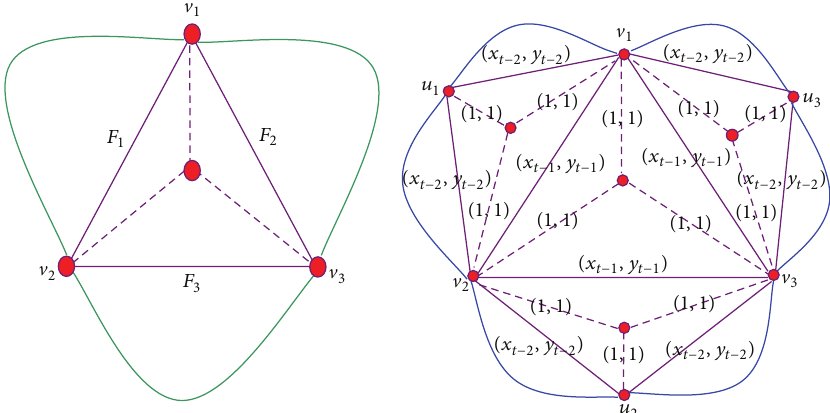
Figure 2: (Color online) the network 𝑀(𝑡) . The solid links are iterated links, the dashed links are noniterated links.